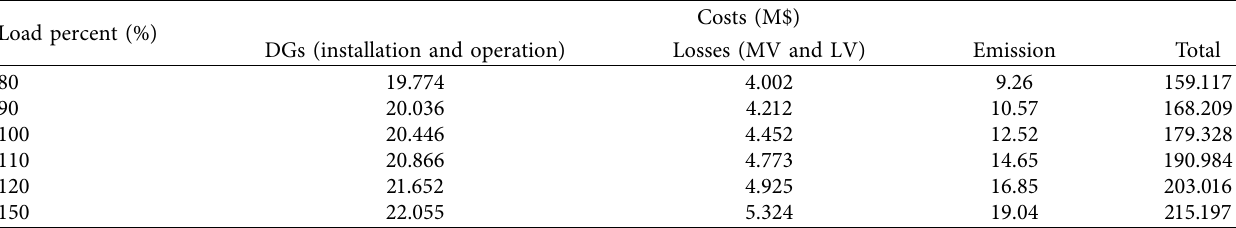
Table 12: Sensitivity analysis on load demand.